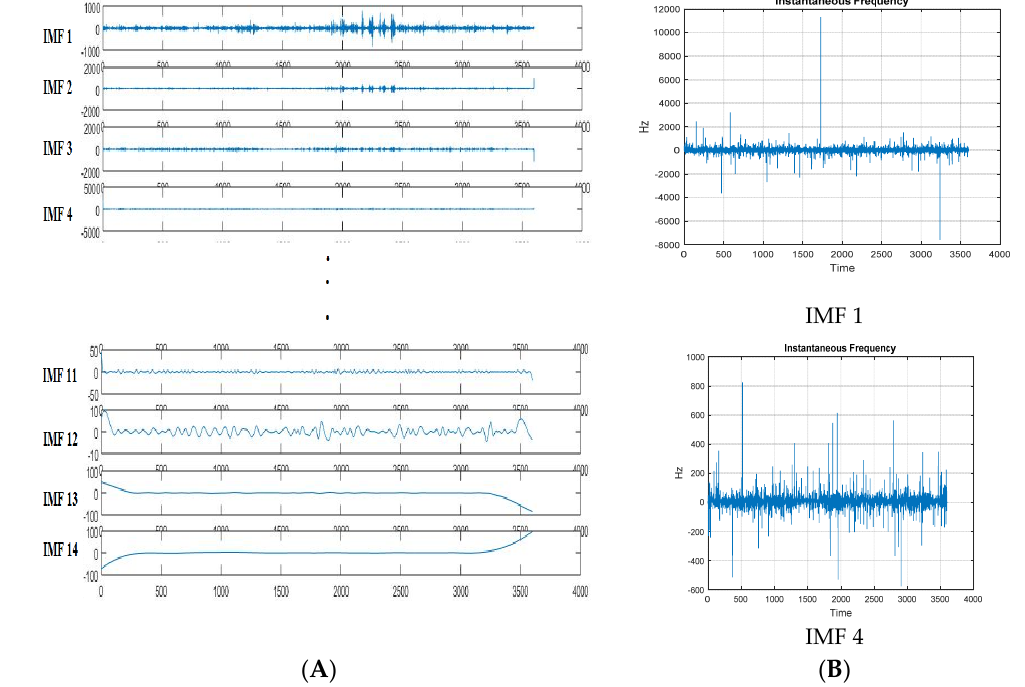
Figure 5. The process of signal decomposition using empirical mode decomposition. ( A ) EEG signal of one electrode decomposed into 14 separate intrinsic mode functions, only the first and last four are shown here for clarity. ( B ) Process of Hilbert transform used to obtain each IMF’s instantaneous frequency information; the example shown here is only for IMF1 and IMF4. Signal was obtained from the CHB MIT database and was single-channel processed using Matlab 2015a.